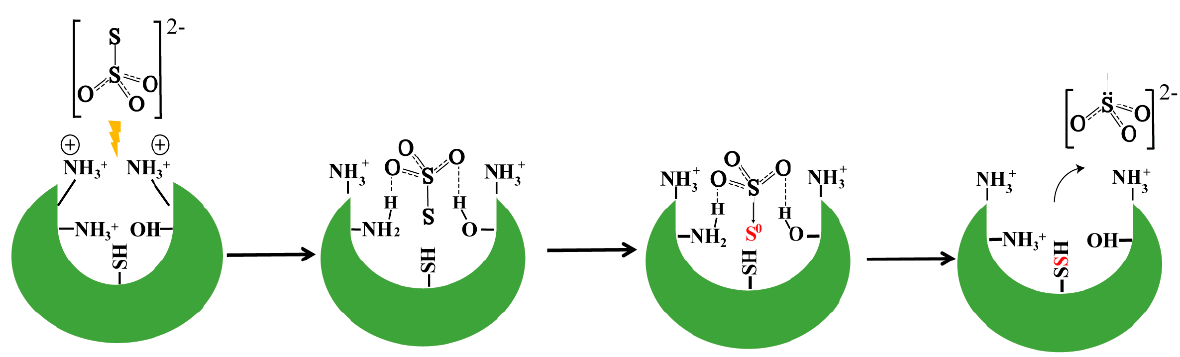
Figure 7. A proposed mechanism for sulfane sulfur transfer from thiosulfate to rhodanese.